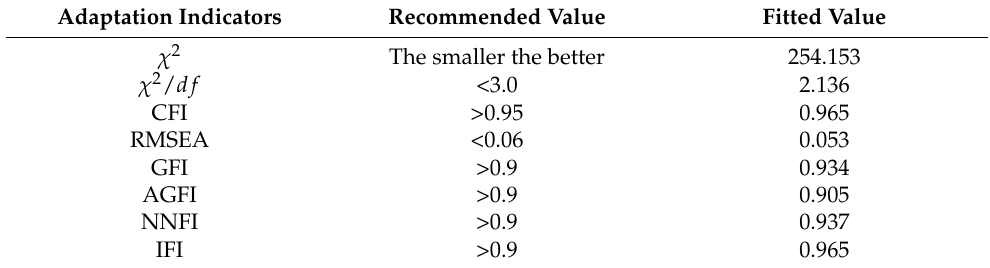
Table 6. Aptitude index values of the structural equation